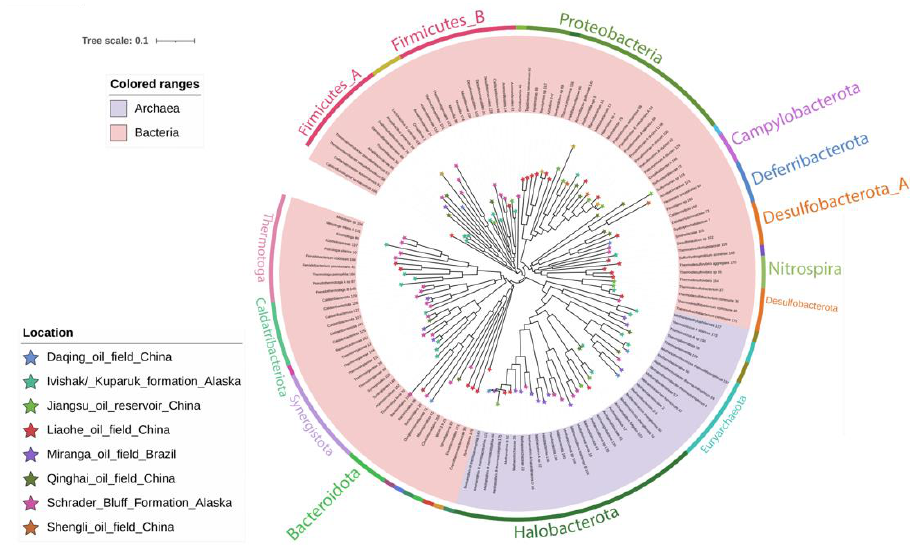
Figure 3. Phylogenetic tree of the 148 MAGs recovered from the oil reservoirs. The tree is decorated with colored backgrounds corresponding to domains, the most represented phyla are labeled in color in the outermost ring. The star shapes in the tips of the branches indicate the location of origin of the MAGs (see legend).